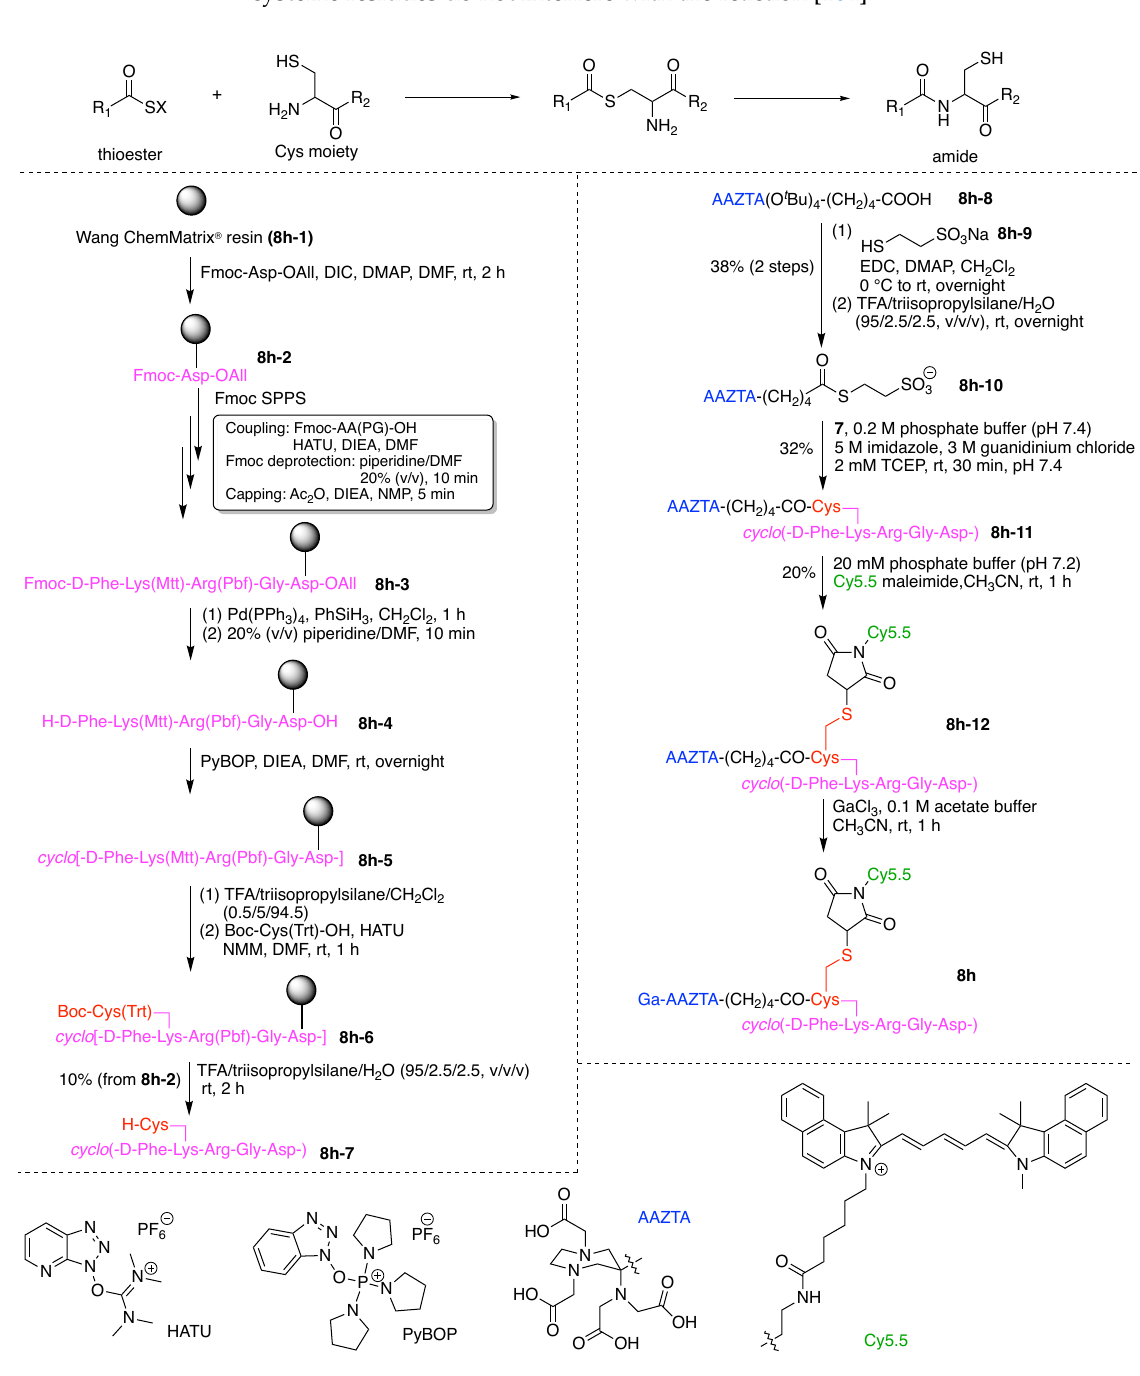
Figure 27. Labeling of cysteine in a cyclic peptide. Native chemical ligation is shown in the top panel. The cyclic RGD peptide unit of 8h was prepared by an on-resin cyclization technique. Thus, Wang ChemMatrix resin ( 8h-1 ) was initially attached onto the side chain of Boc-Asp- All ( 8h-2 ) (Figure 27), where All indicates the allyl group. Standard Fmoc SPPS was per- formed to obtain a fully protected linear RGD peptide ( 8h-3 ), whereupon the N -terminal Fmoc and C -terminal All groups were selectively deprotected. The coupling chemistry was carried out using N,N -diisopropylcarbodiimide (DIC) or O -(7-azabenzotriazol-1-yl)-